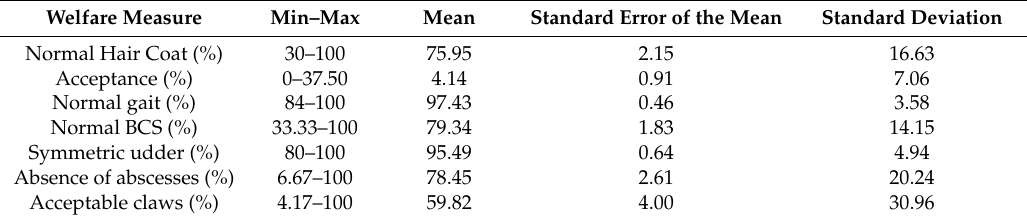
Table 3. The proportion of animals with no welfare problems for the selected animal-based quantitative measures calculated at the pen